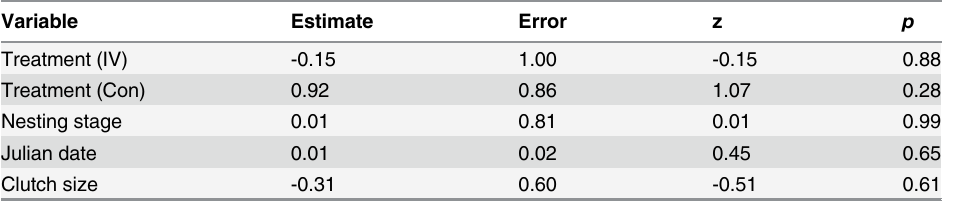
Table 5. Summary of binomial GLMM outputs.